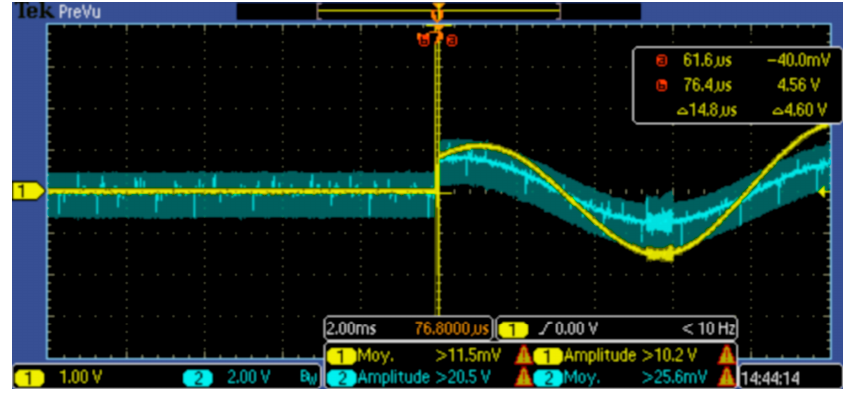
Figure 1. Characterisation test of the device displayed by an oscilloscope.